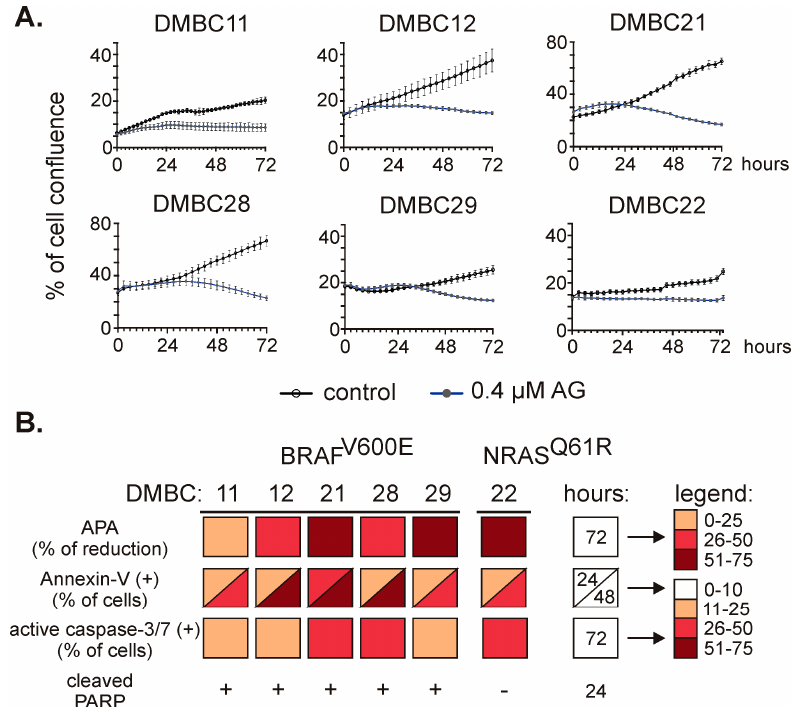
Figure 2. The effect of 17-aminogeldanamycin (AG) on cell viability in BRAF V600E and NRAS Q61R melanoma cell lines. ( A ) Melanoma cells were exposed to AG at 0.4 µM. Cell confluence was assessed over the course of 72 h by time-lapse imaging system IncuCyte ZOOM. Data presented are mean ± SD of a representative experiment performed in duplicate; n = 3. ( B ) Cell viability and induction of apoptosis were assessed in melanoma cell cultures exposed to AG at 0.4 µM using acid phosphatase activity (APA) assay, annexin-V/propidium iodide staining followed by flow cytometry, real-time fluorescence microscopy (% of cells with active caspase-3/7), and Western blotting (cleaved PARP). The color-coded summary of the results is shown at indicated time points. The percentages of annexin-V-positive cells and cells with active caspase-3/7 in the controls did not exceed 10%. The original results for DMBC11 cells are shown in Figure S1; for other cell lines, they are published elsewhere [21].